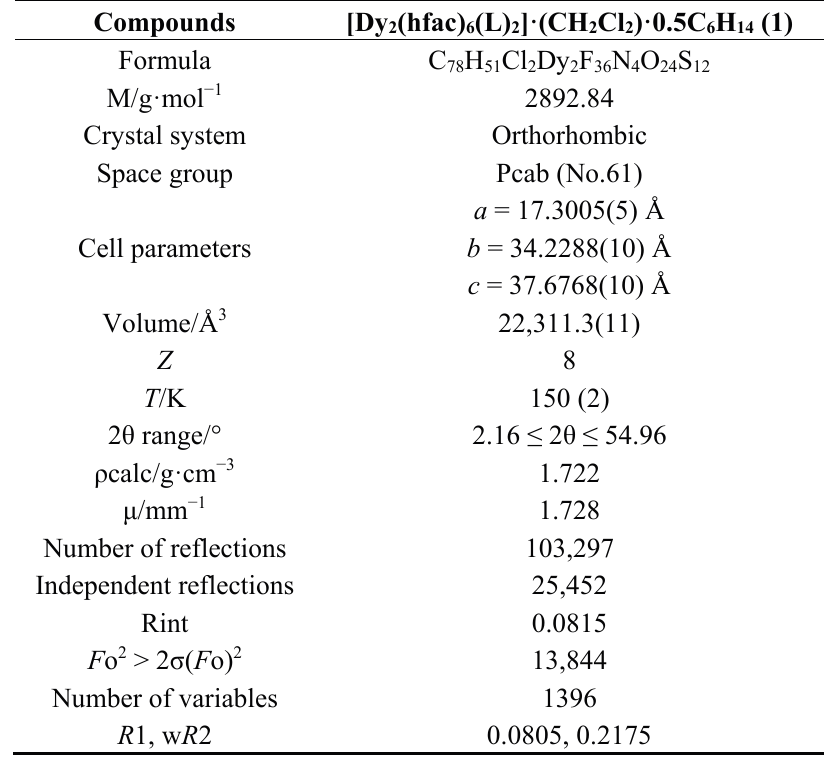
Table 1. X-ray crystallographic data for 1